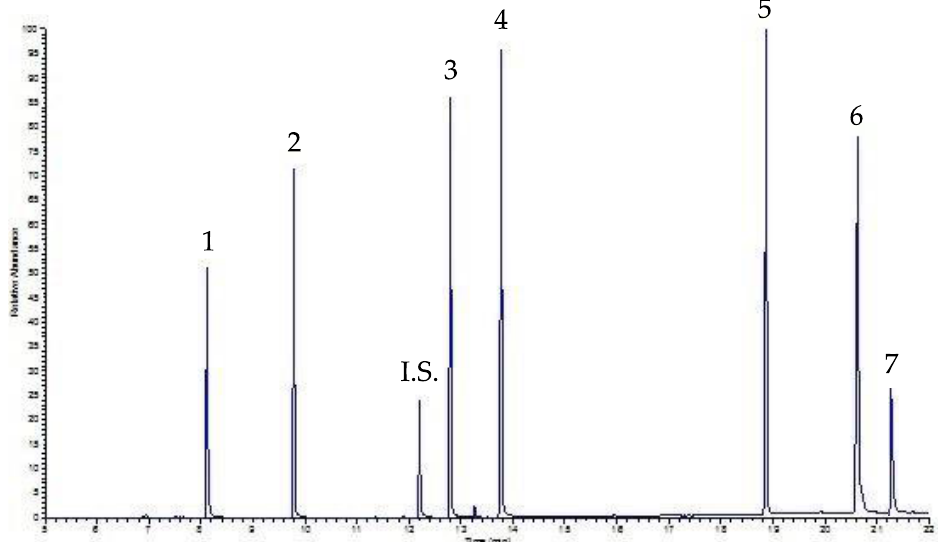
Figure 5. UVA-DLLME-GC-FID chromatogram of a coffee sample spiked with 30 µg mL −1 of each PAE. Peaks: see Figure 4; for experimental conditions: see text.